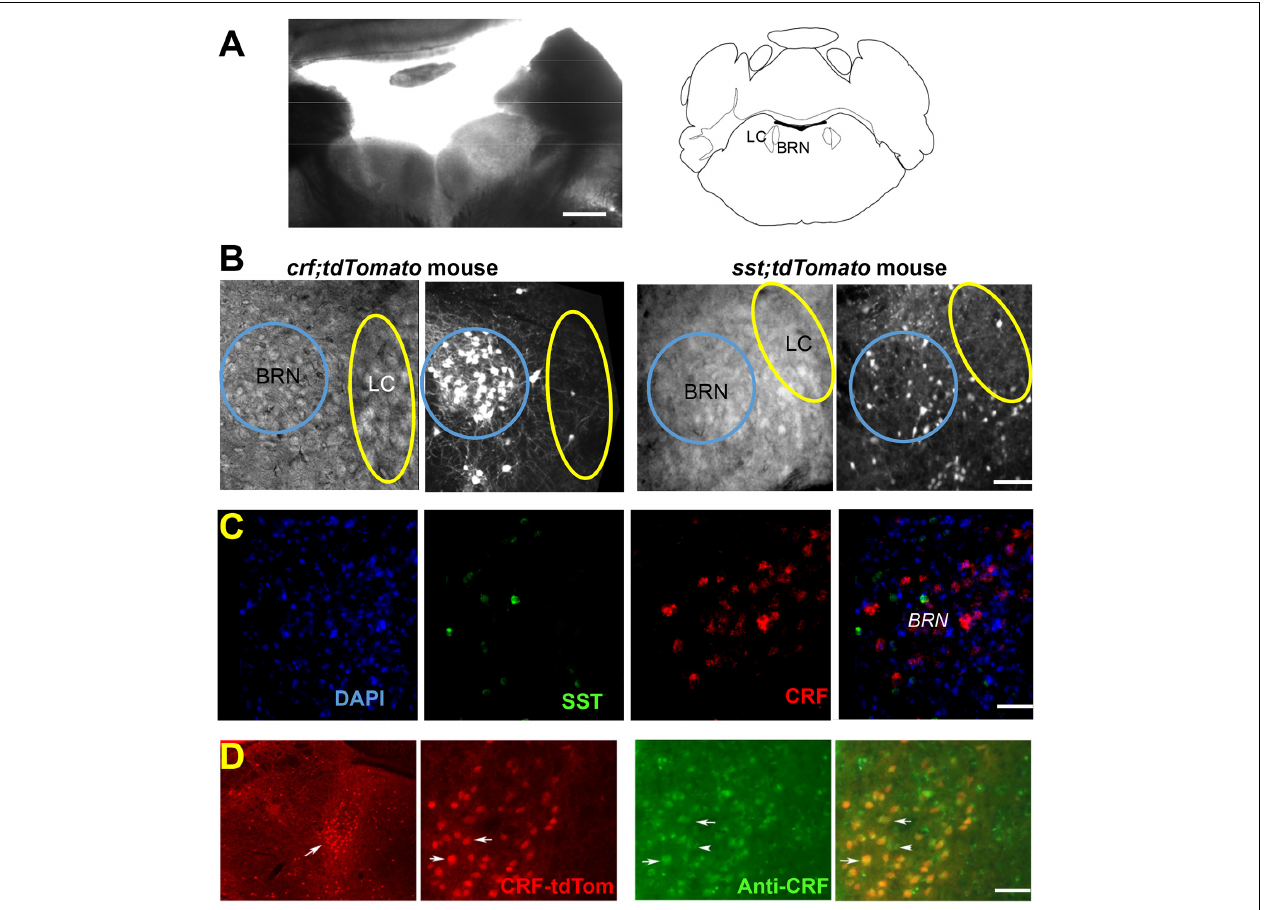
FIGURE 1 | Identification of neurons in Barrington’s Nucleus/Locus Coeruleus area. (A) Low magnification bright-field image shows the location of BRN and LC in an example coronal slice from a Crf Cre ;tdTomato mouse at postnatal day 28 together with the Brain Atlas map, adapted from Franklin and Paxinos (1997). Scale bar = 0.5 mm. (B) DIC and fluorescence tdTomato expression images. Crf Cre ;tdTomato expressing neurons (left) are seen as a bright cluster of high neuronal densities in the BRN. tdTomato expression in SST + neurons is seen at a lower density (right) in an example slice from Sst Cre ;tdTomato mouse. The areas of the BRN and LC are indicated by a blue or yellow circle, respectively. Scale bar = 50 µ m. (C) RNAscope R (cid:13) in situ hybridization of CRF mRNA (red) and SST mRNA (green) does not overlap in BRN. First panel DAPI (blue), second panel CRF (red), third panel SST (green), and fourth panel overlap of all three channels. Scale bar = 50 µ m. (D) Immunodetection of CRF in BRN neurons (Barr, white arrow) expressing tdTomato. Low magnification images, illustrate the extent of red fluorescent CRF + neurons in sections containing the BRN (Barr, white arrow) and the LC (left). Anatomical distribution is compared at higher magnification between CRF mediated tdTomato expression labeled CRF-tdTom (red), anti-CRF antibody staining (green), and merged images (yellow), indicating accurate transgene expression. Example co-labeled cells indicated by white arrows. Scale bars 1 mm (left) and 50 µ m (all other